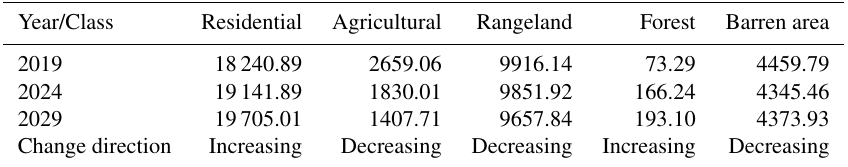
Table 5. Predicted changes to land use/cover in the period from 2019 to 2029 (in hectare).